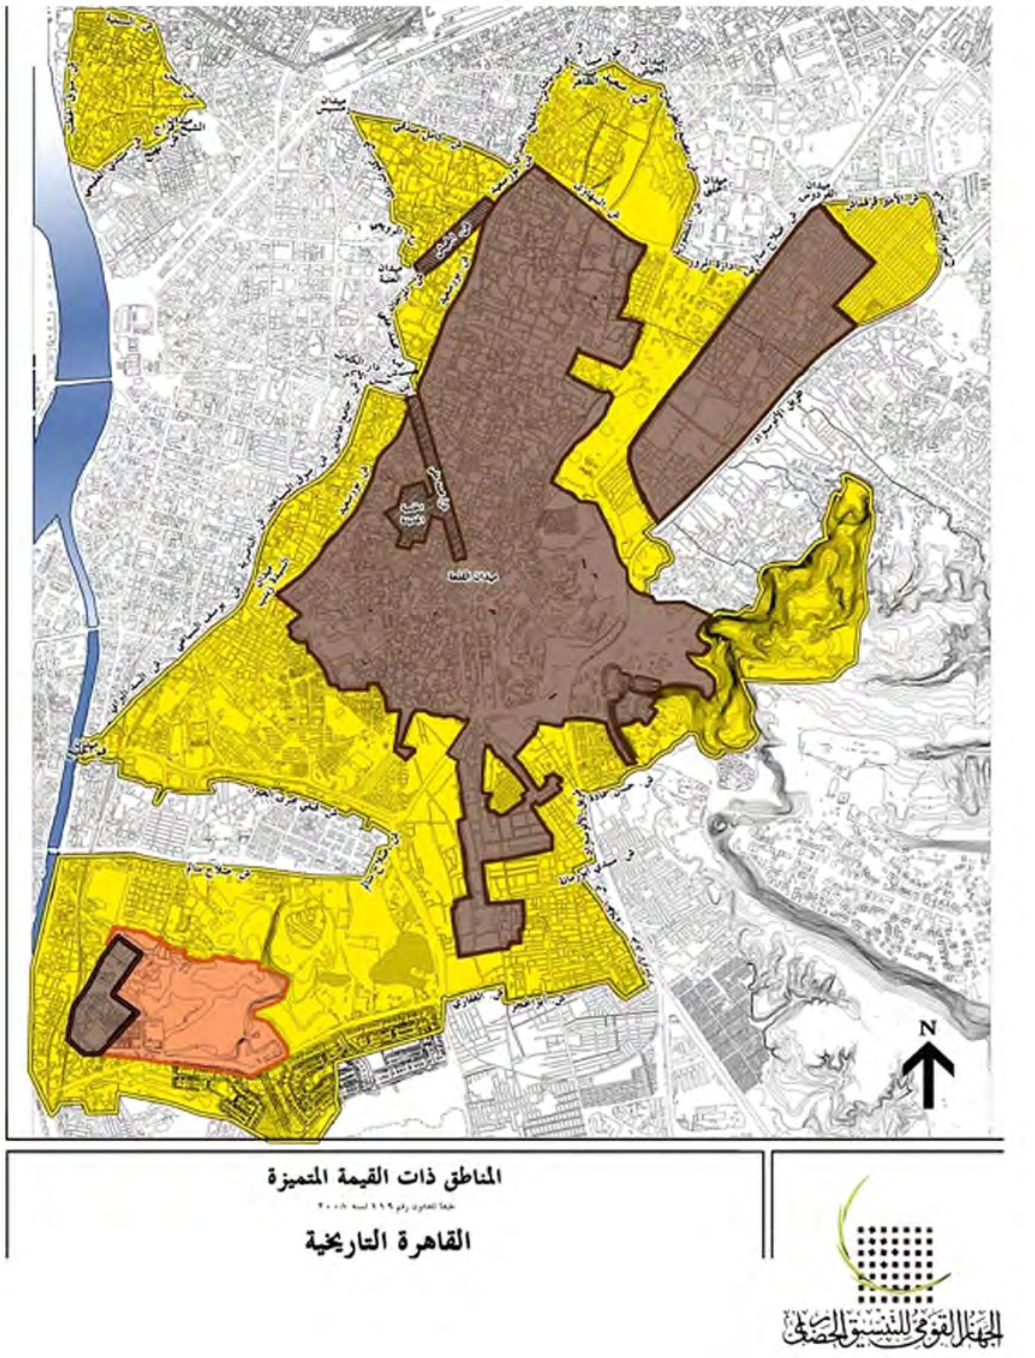
Figure 8. Boundaries of Historic Cairo zones under protection (National Organization for Urban Harmony)